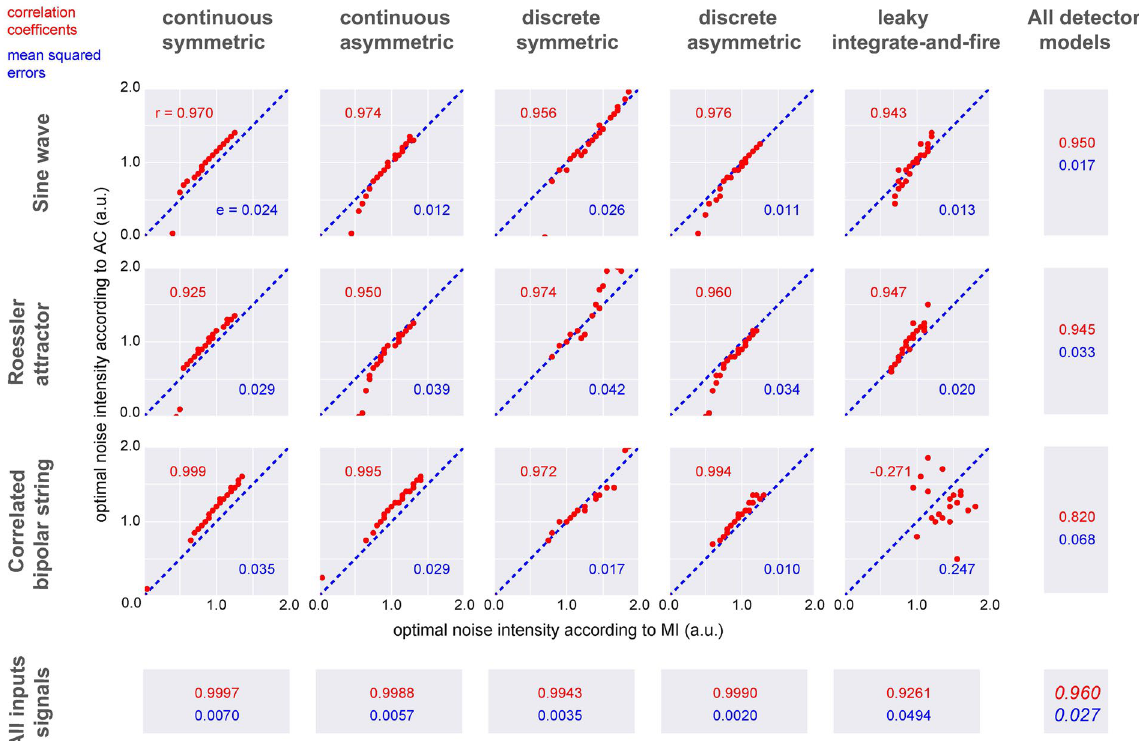
Figure 5. Correlation between optimal noise level from mutual information versus output autocorrlation. Numerical data from 5 sensor models, 3 different input signal, and different signal-to-threshold distances. The optimal noise intensities found by maximizing the mutual information (x-axes) are plotted versus the optimal noise intensities found by maximizing the output autocorrelation (y-axes). Except for correlated bipolar strings in combination with a leaky integrate-and-fire sensor, the optimal noise levels from both methods are highly correlated, with an overall correlation coefficient of r = 0.960 and a mean squared error of e =